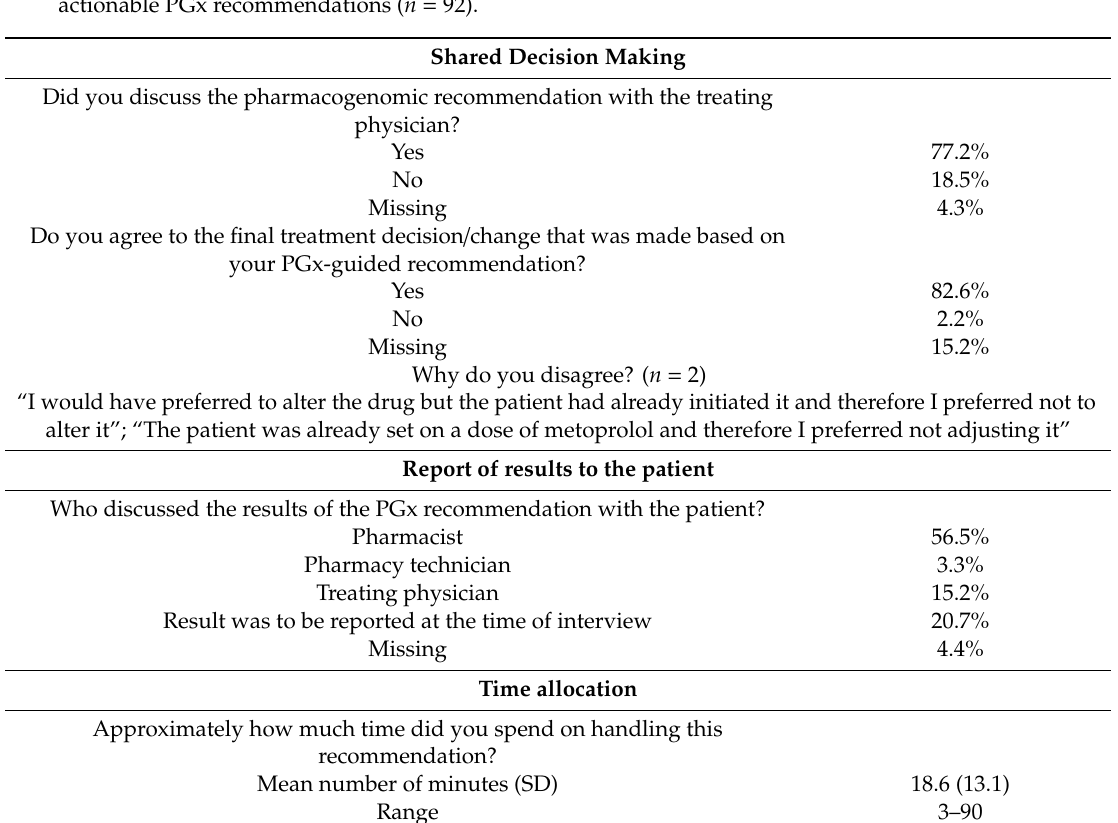
Table 2. Shared decision making, report of results to patients, and time allocation, as a result of actionable PGx recommendations ( n =